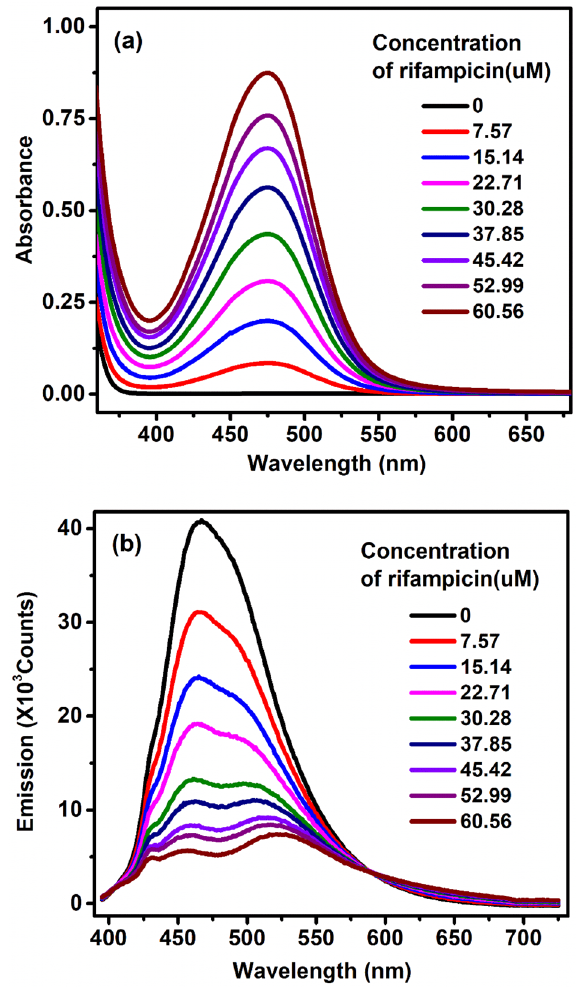
Figure 2. ( a ) Absorbance spectra of Rifampicin (RF) in 50 mM CTAB micelles for concentrations 0–60.56 µM. ( b ) Emission spectra of benzothiazole in 50 mM CTAB without and with varying concentrations of RF from 0 to 60.56